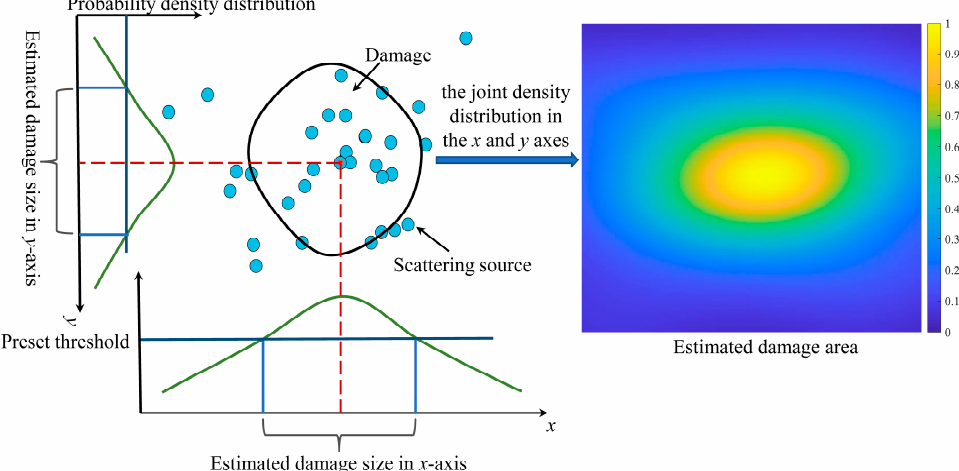
Figure 7. Damage area estimation method.